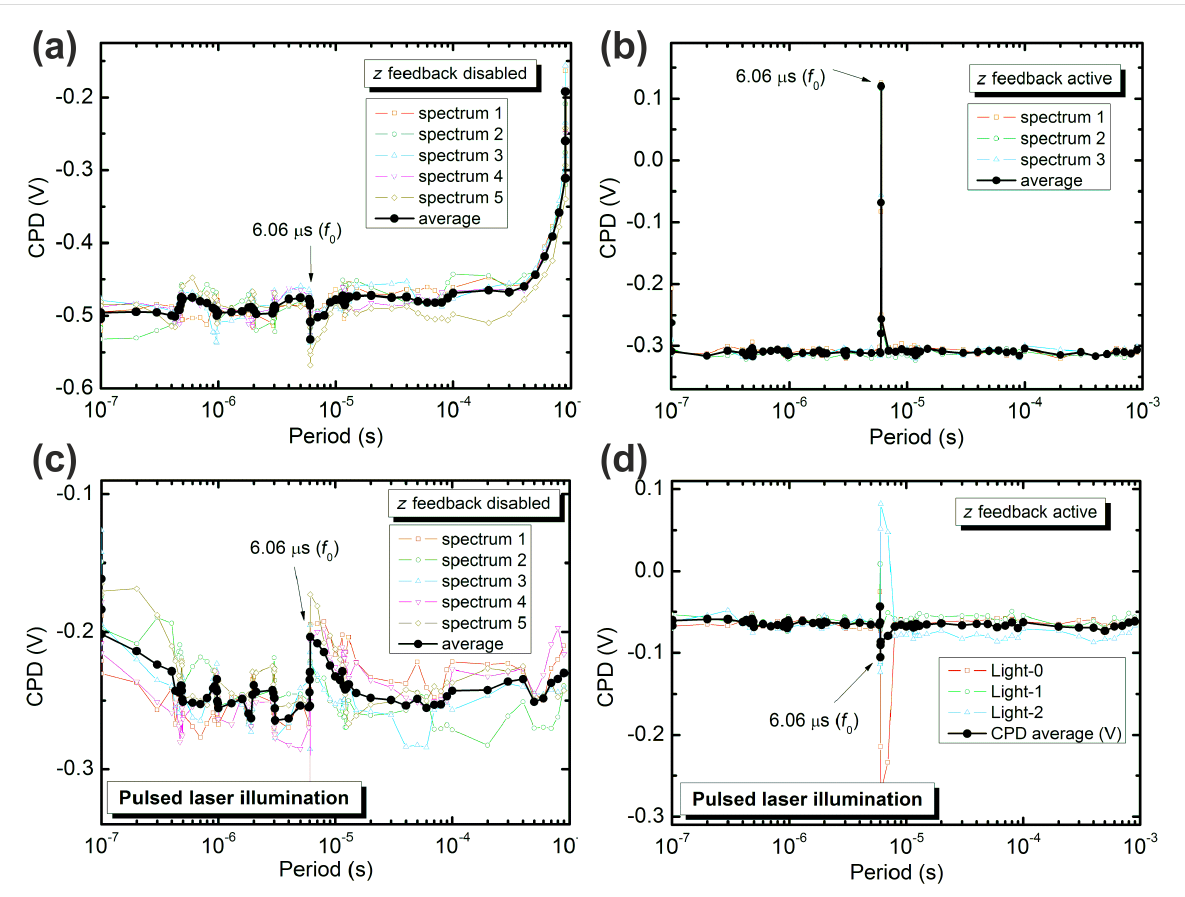
Figure 5: Experimental frequency spectra with a square shaped pulse of 50% duty cycle measured by FM-KPFM ( f ac = 377 Hz, V ac = 200 mV). Bias pulses applied to the Au(111) sample with the z feedback (a) disabled and (b) active, leading in both cases to some deviation from the expected CPD at the fundamental resonance frequency of the cantilever. Light pulses lead to similar deviations for (c) disabled and (d) enabled z